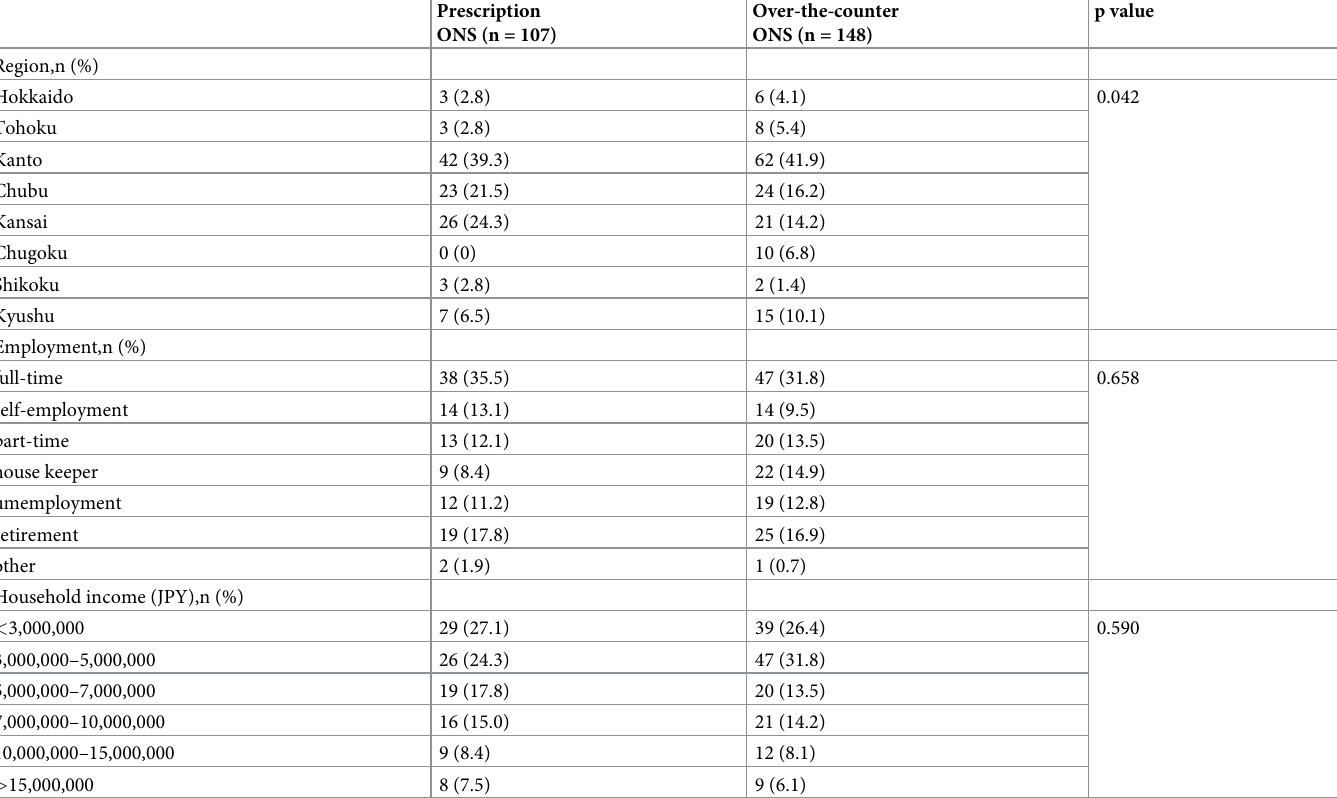
Table 4. Region,employment and household income of